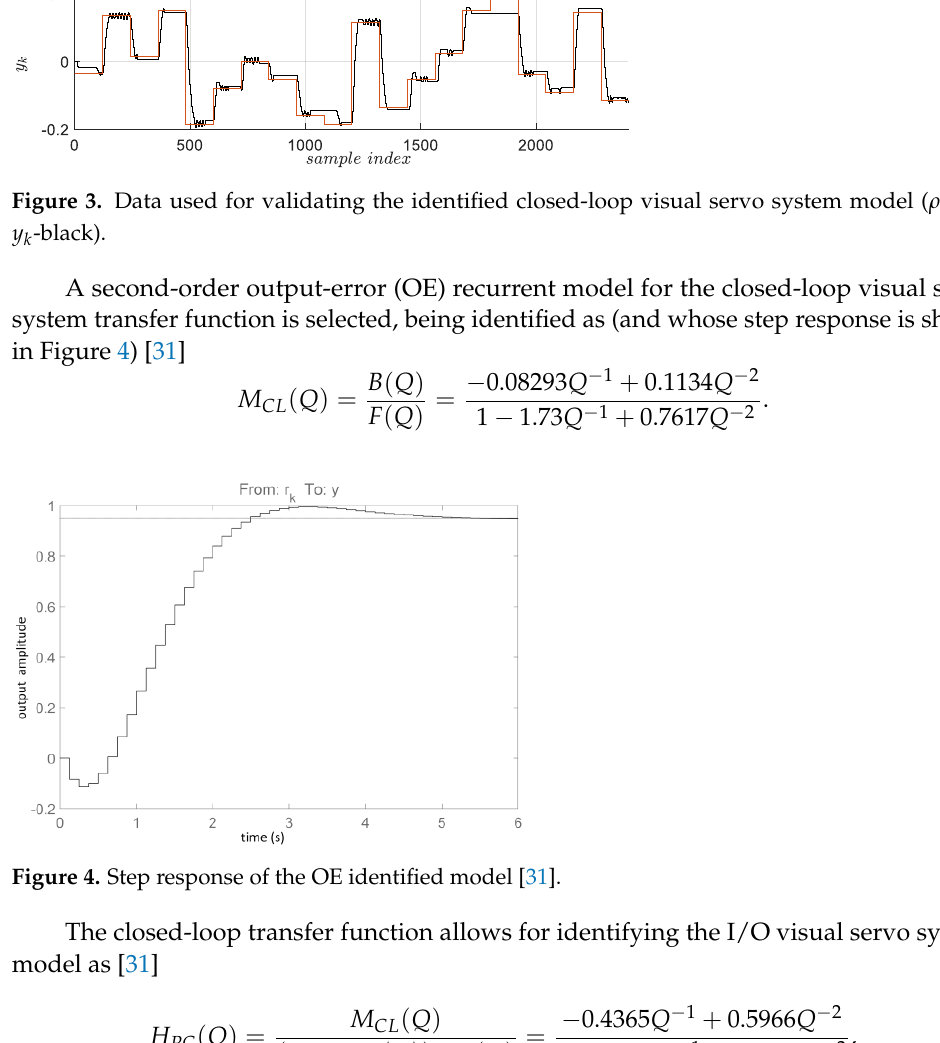
Figure 1. Hardware connection between the engine, motor driver and Arduino Board [31].